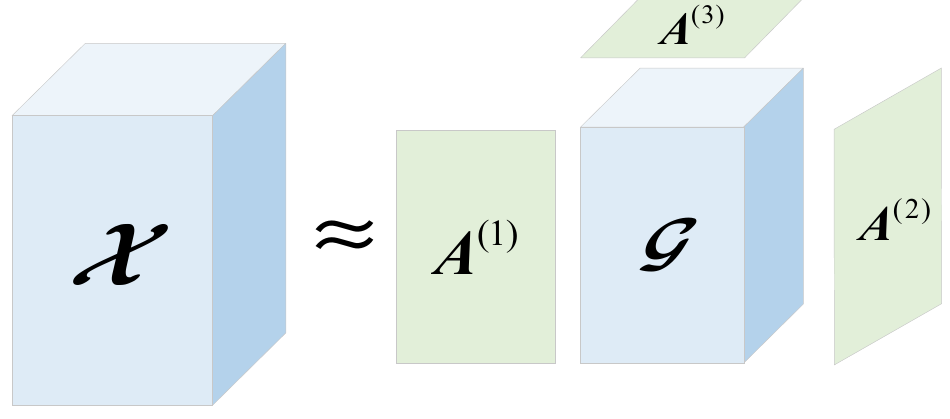
Figure 1. Schematic diagram of Tucker decomposition.